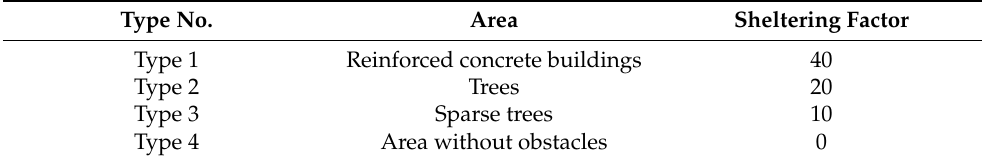
Table 1. Different sheltering factors in different areas. Type